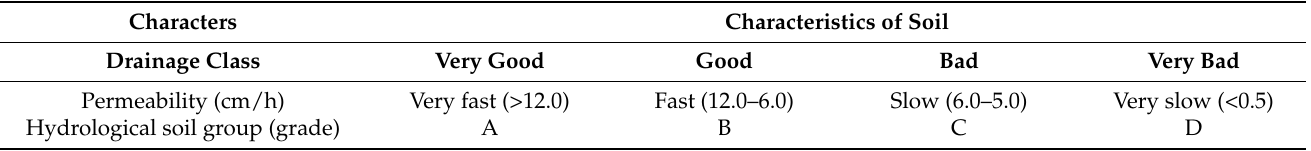
Table 1. Characteristics of soil in four central western major streams of the Korean Peninsula between 2013 and